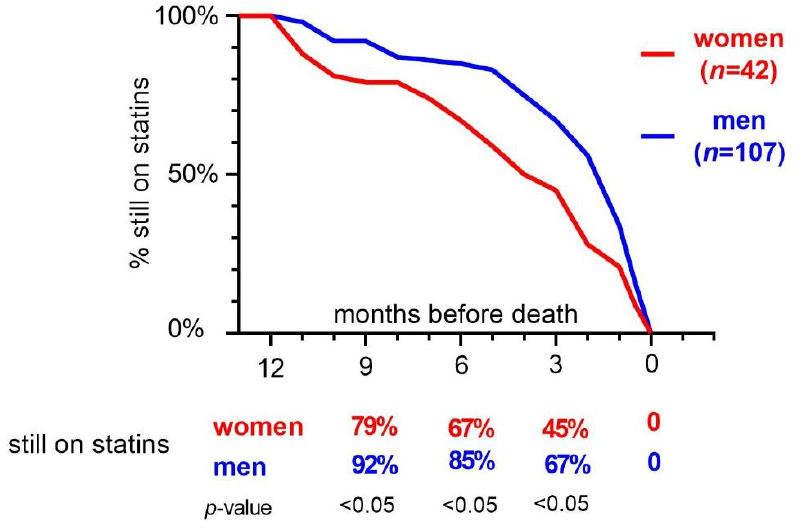
Figure 2. Time-graph when statin was terminated in men ( n = 107) and women ( n = 42) in relation to death during the last year in life. All patients had a cancer diagnosis more than one year before death. Table 2. Time-point for statin-termination and outcome in cardiovascular events after statin termination. Comparison between men and women and if the indication for statin treatment was primary prevention or secondary prevention, i.e., treatment initiated after previous cardiovascular event. Statistical analysis were performed by Mann–Whitney-U test. MI = myocardial infarction, IQR = interquartile range.